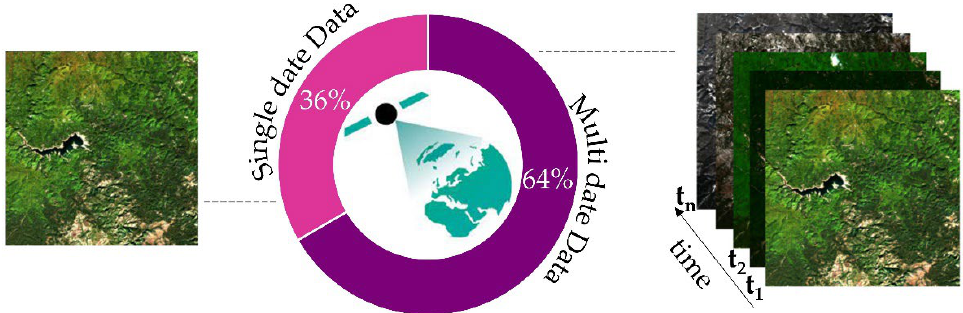
Figure 14. Frequency of single- and multi-date RS data usage in wetland studies.